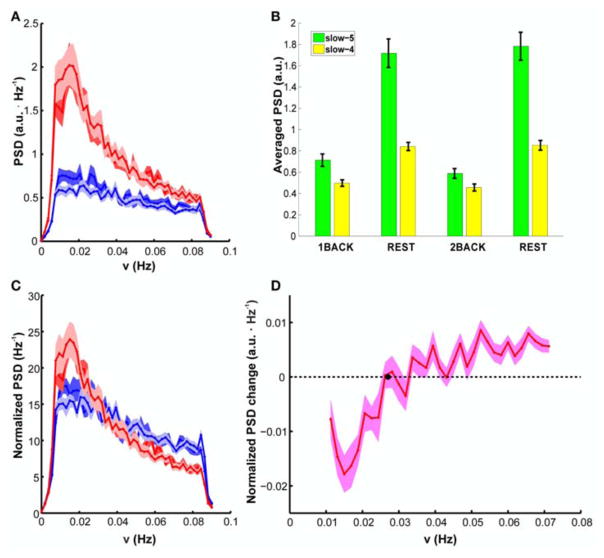
PSD group results: (A) PSD of BOLD fluctuations in the DMN, averaged in each epoch. Resting-state epochs are represented in red, task epochs in blue (dark blue is 1 back, light blue is 2 back). Task-related changes in spectral power are visible. (B) PSD averaged in the slow-4 (green) and slow-5 (yellow) range. Slow-5 presents higher integrated power in all epochs. Power was always higher at rest than during task, but in a frequency specific manner (significant interaction stimulation condition x frequency band). The two task levels were indistinguishable. See Results Section for p-values. (C) Normalized PSD. In normalized PSD a steeper dependence on frequency during resting state than during task performance is apparent. (D) Difference between normalized PSD during task execution and resting state as a function of frequency. All values are mean ± SEM across subjects. SEM is computed after within-subject averaging of corresponding data from the two runs.